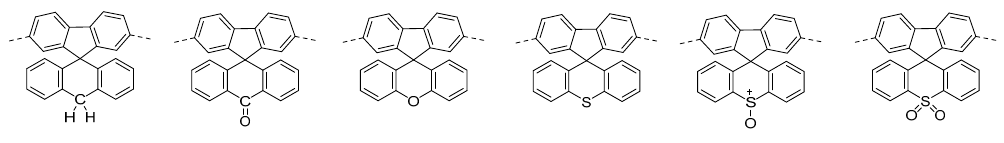
Figure 1. Molecular structure of target spirocycles.